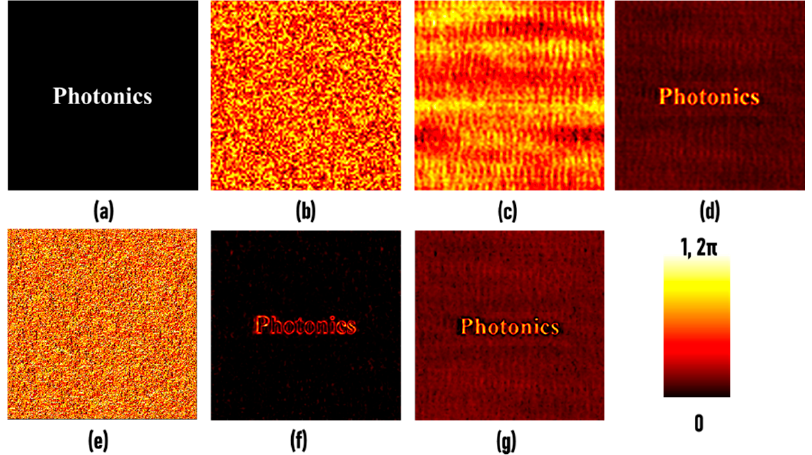
Figure 4. ( a ) Test object. ( b ) I PSH . ( c ) Object hologram. ( d ) Reconstructed image. ( e ) Phase of the synthetic PSH. ( f ) Edge-enhanced reconstruction and ( g ) contrast and resolution enhanced image.